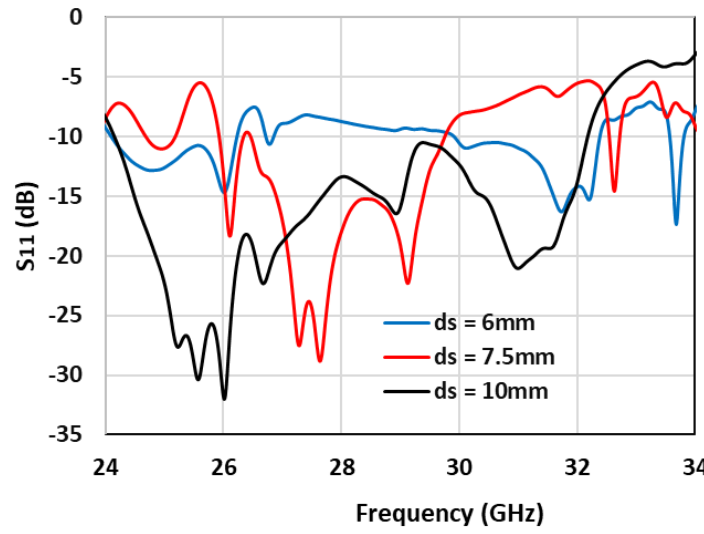
Figure 7. |S 11 | of the DRA arrays for various separation distances (d s ).